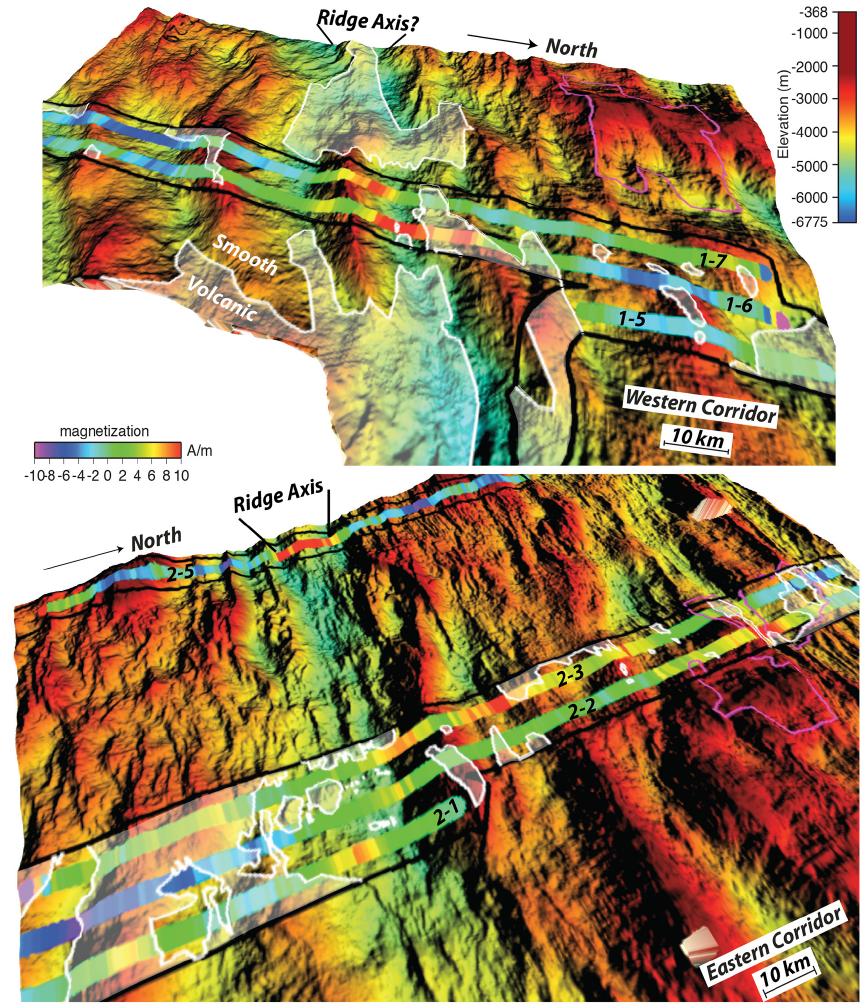
Figure 4. Three-dimensional bathymetric view of the two survey areas. The inverted magnetization (colored strips) and the edges (from Sauter et al., 2013) of both the corrugated surfaces (purple lines) and the volcanic seafloor (white faded areas) are draped on the multibeam bathymetric map. The magnetization scale is the same for the two survey areas. The black lines indicate the edges of the TOBI side-scan